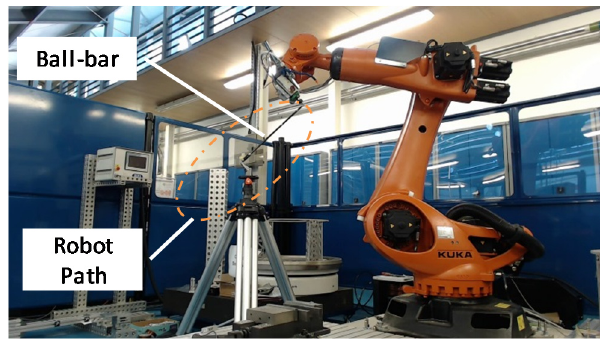
Figure 16. Ballbar test in progress.